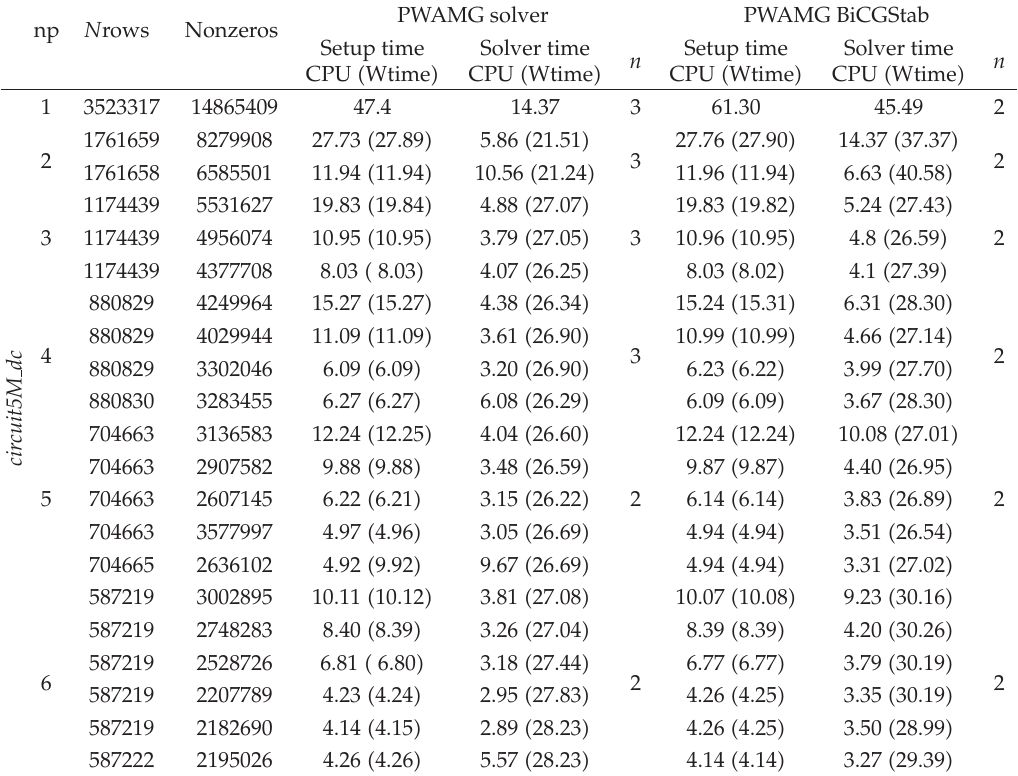
Table 5: Parallel results for circuit5M dc